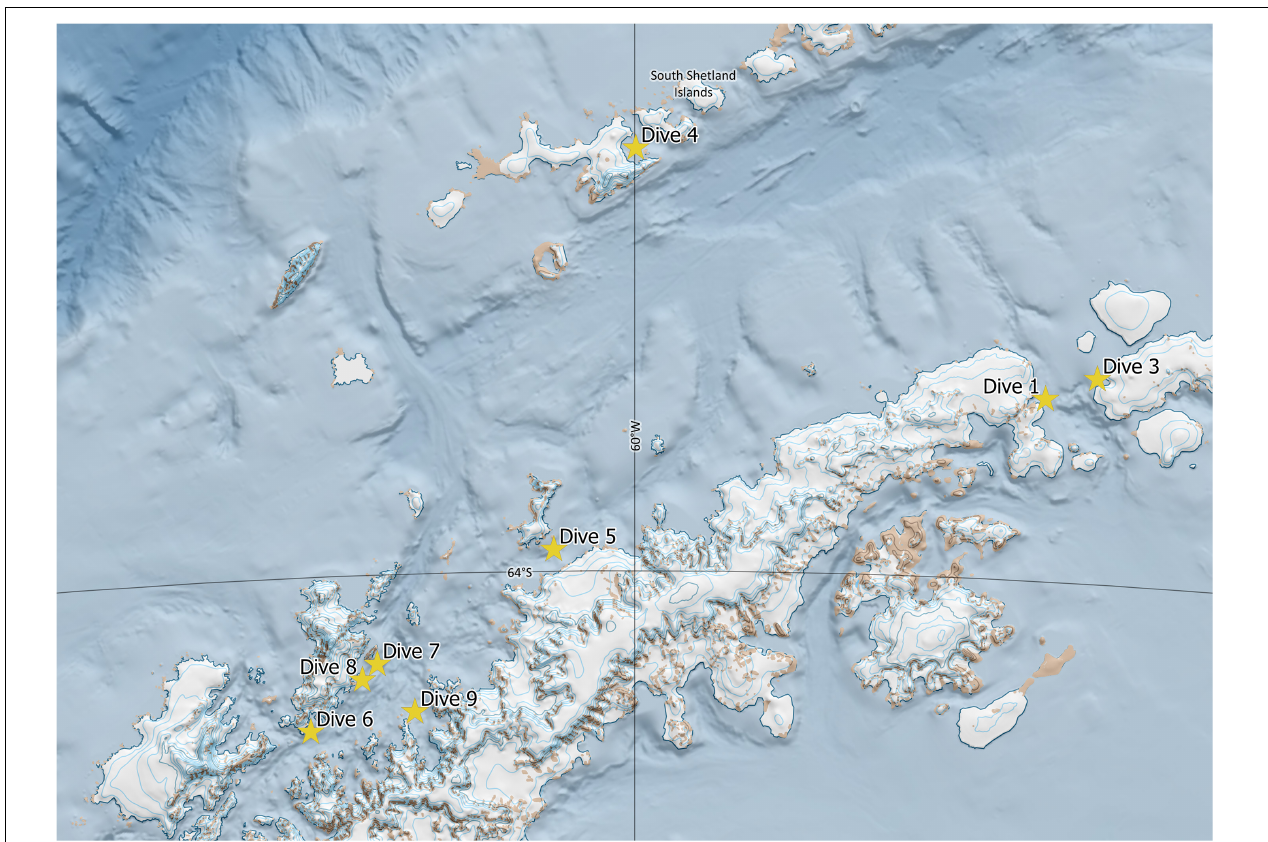
FIGURE 2 | Map of successful dive sites during the January, 2018, M/Y Arctic Sunrise expedition. Generated with QGIS (http://qgis.osgeo.org) software (QGIS Development Team, 2019) using the Quantarctica package provided by the Norwegian Polar Institute.